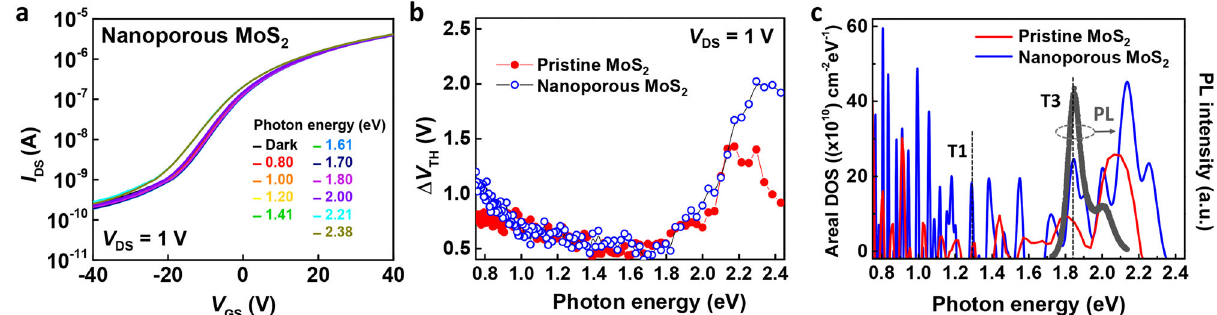
Fig. 3 Optoelectronic characteristics of MoS2 TFTs. a Photo-excited transfer characteristics of the multilayer nanoporous MoS 2 TFT under monochromatic light illumination with various wavelengths. b Dependence of Δ V TH on the incident photon energy, which was extracted from individual photo-excited transfer curves of the MoS 2 TFTs. c Photon energy-dependent areal DOS pro fi les of the multilayer pristine and nanoporous MoS 2 TFTs. The photoluminescence (PL) spectra (bold gray line) of the nanoporous MoS 2 is overlaid on the graph to compare the peak position observed by PECCS and the interband transitions measured